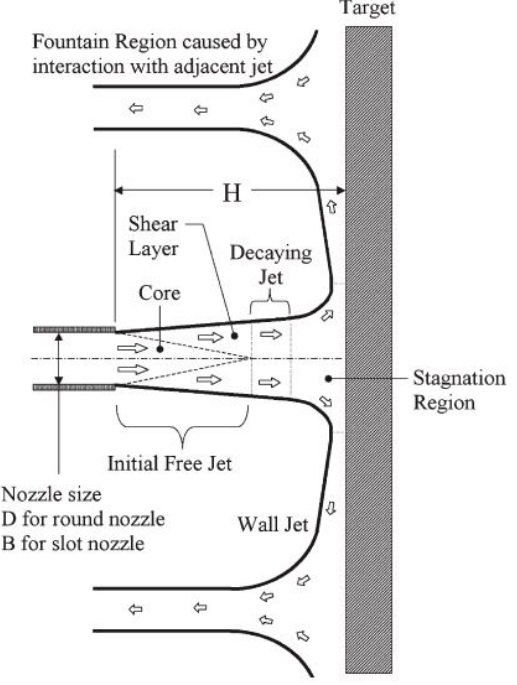
Figure 1. Flow regions of a jet impingement [1].